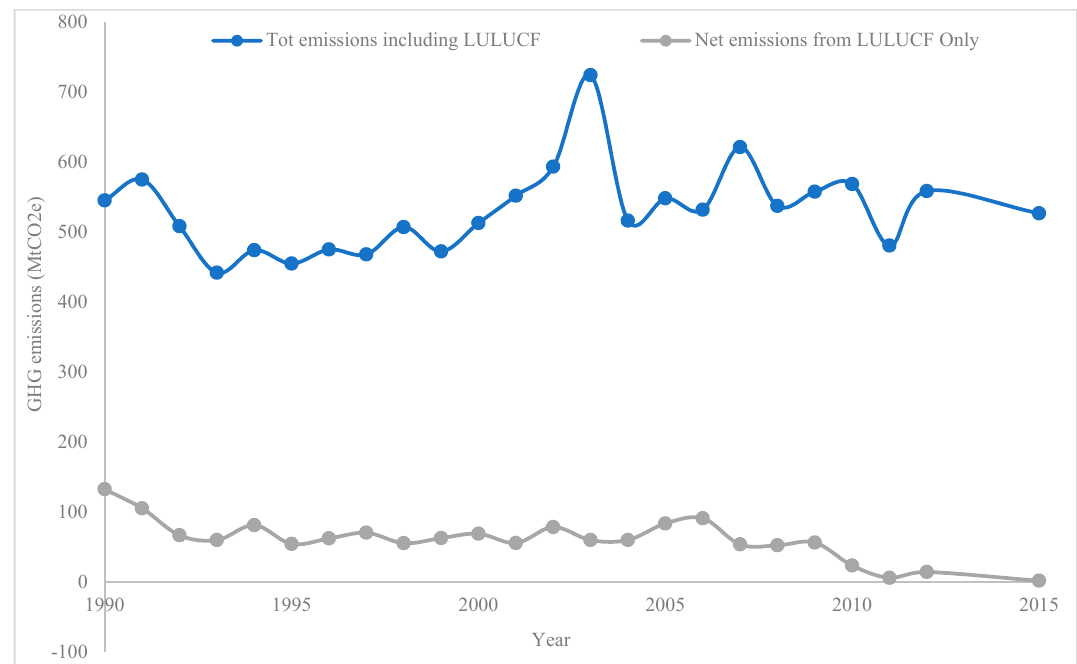
Figure 1. Greenhouse gas (GHG) emissions from Australia during the 25 year period, 1990–2015. (Data sources: total GHG emission data for year 1990 to 2012 from the UNFCCC [30]; year 2015 data from Australian Government (2016a/b); net emissions from land use, land use change, and forestry (LULUCF) data from Department of Environment and Energy [31].